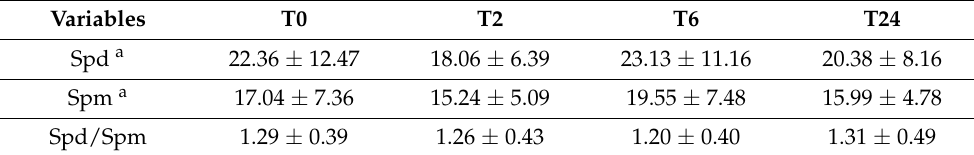
Table 6. Blood spermidine and spermidine